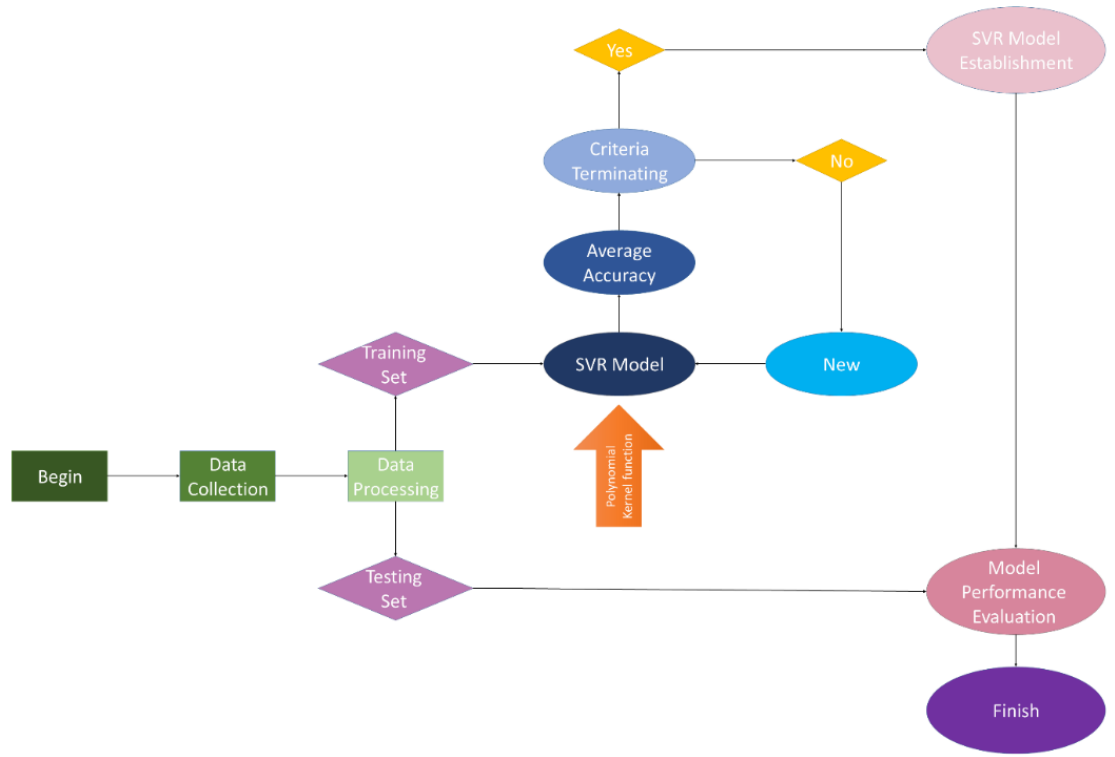
Figure 9. The sequence of steps in the SVR